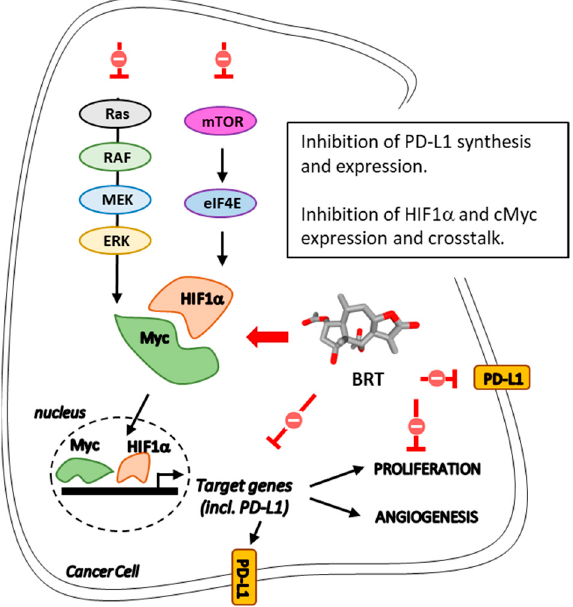
Figure 6. Modulation of the cMyc-HIF1 α pathway by BRT. The compound downregulates expression of both cMyc and HIF1 α , presumably via an interference with upstream effectors, such as mTOR and Rs/RAF. BRT also inhibits the direct interaction between cMyc and HIF1 α . These different actions lead to a reduction in expression of specific proteins, including PD-L1, of which membrane expression is massively attenuated by BRT. These effects lead to inhibition of angiogenesis and cancer cell proliferation (adapted from [67]).